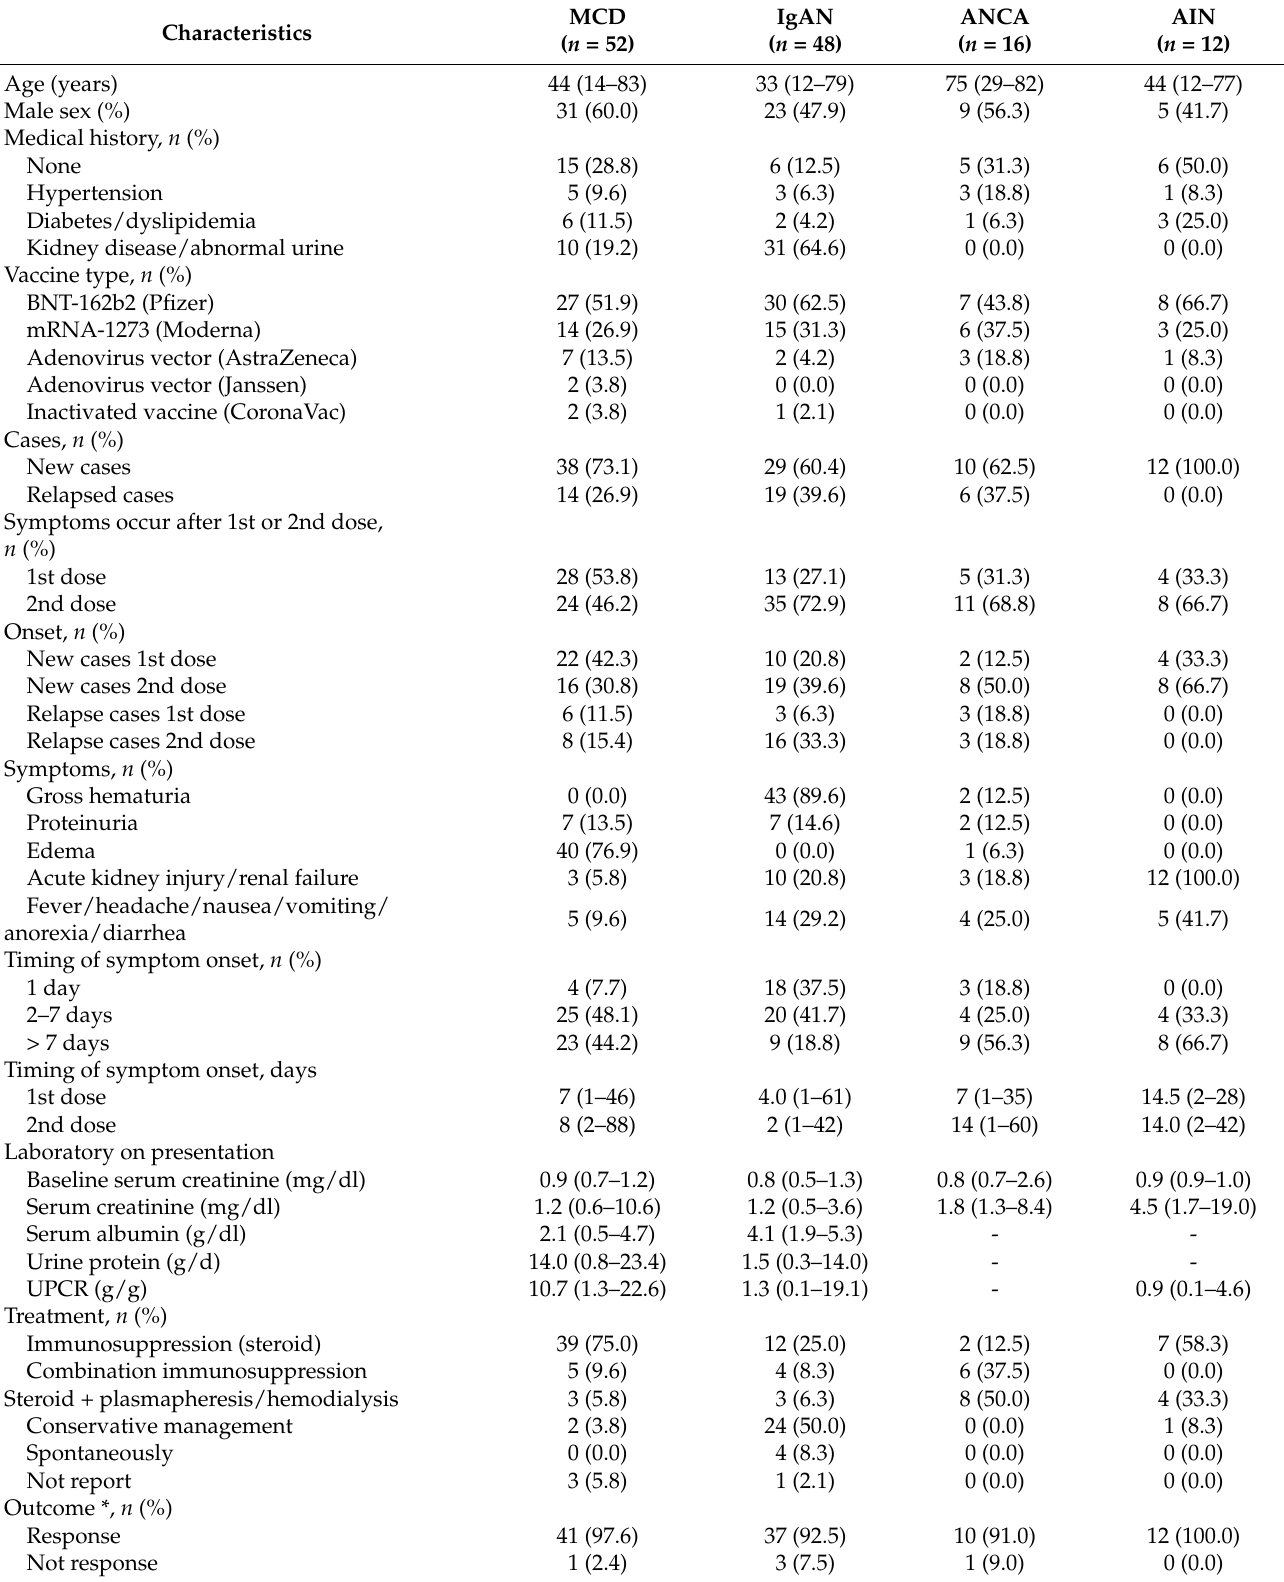
Table 1. Clinical characteristics of patients with MCD, IgAN, ANCA or AIN following COVID-19